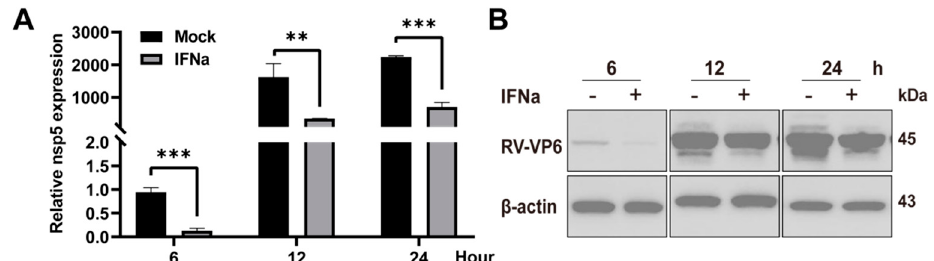
Figure 1. IFNa2b restricts RV infection. Caco2 cells were preincubated with IFNa2b for 12 h and subsequently infected with the Wa strain at 0.2 MOI. ( A ) RT–qPCR analysis of Wa–NSP5 of Caco2 cells infected with the Wa strain at 0.2 MOI for a certain time. Results represented the mean ± SD and were measured in technical duplicates, n = 3. **, p < 0.01; ***, p < 0.001 (Student’s t test). ( B ) Western blot analysis of Wa–VP6 in cell lysates at 6, 12 and 24 h post infection.